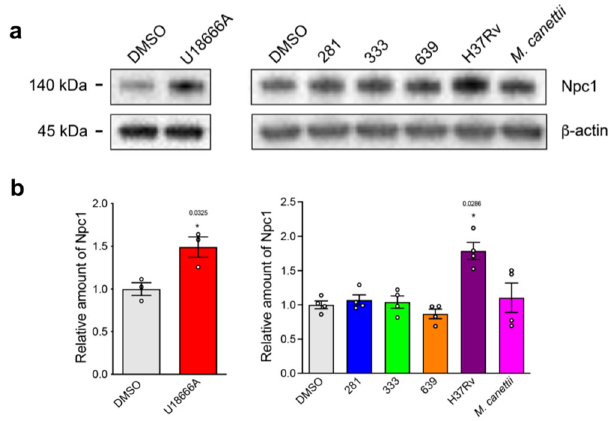
Fig. 4 | Exposure to lipid extract of strain H37Rv signi fi cantly increases the expression of NPC1 in RAW 264.7M Φ . a Western blot of protein lysates of RAW 264.7M Φ that had been incubated with vehicle or mycobacterial lipid extracts for 48h.Upperband,blotprobedforNpc1andlowerband,blotre-probed for β -actin. b Quanti fi cation of Npc1 protein bands normalized to β -actin, relative to vehicle treatment. Data are mean±SEM, N =2 or 3. Statistical analysis, t test with Welch ’ s correction, two-tailed. p values as indicated, otherwise not signi fi cant. The blot is representative of three independent experiments. Source data are provided as a Source data fi